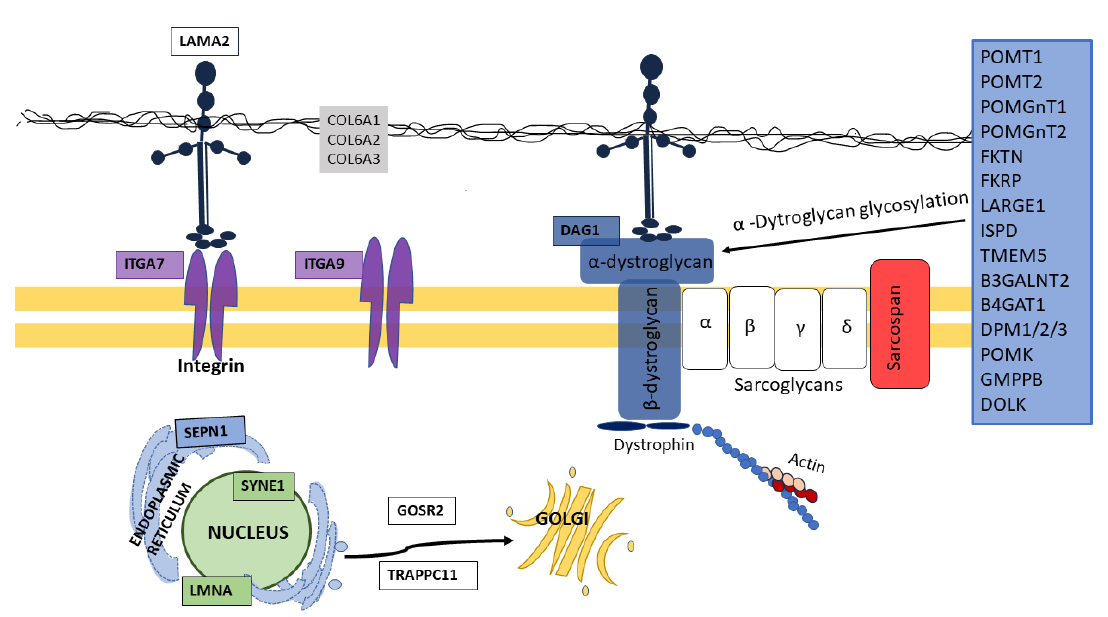
Figure 2. Schematic representation of the Dystrophin glycoprotein complex (CDGP) in skeletal muscle. The two dystroglycan subunits (α-DG and β-DG) interact non-covalently to form a bridge between the extracellular matrix and the actin cytoskeleton. The cytosolic domain of β-DG is anchored to actin through interaction with dystrophin. α-DG interacts with the ectodomain of β-DG on the extracellular side of the plasma membrane. DG acts as a receptor for extracellular matrix proteins such as laminins. Adapted from Brancaccio 2019.